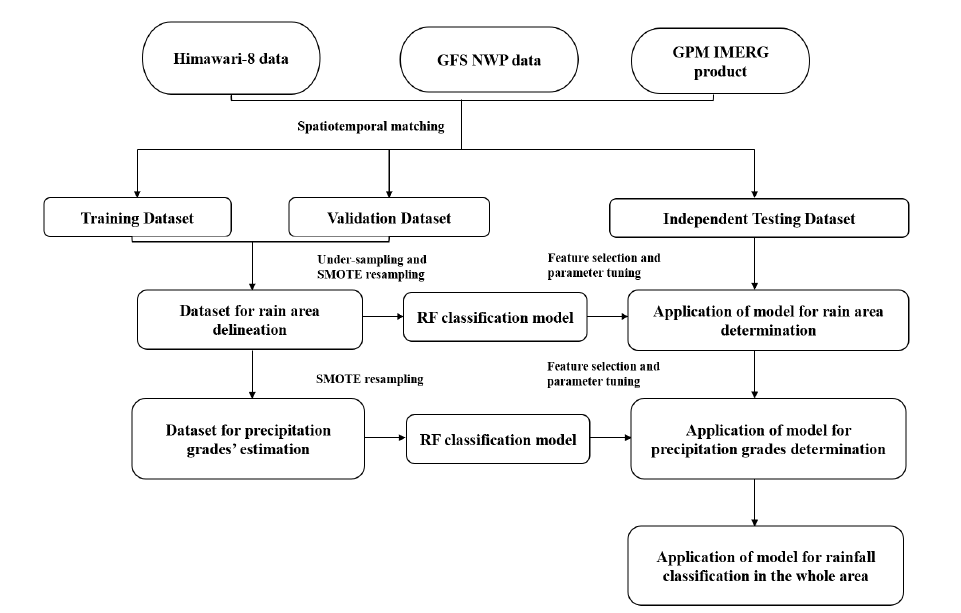
Figure 2. Framework of the two-step RF-based precipitation retrieval